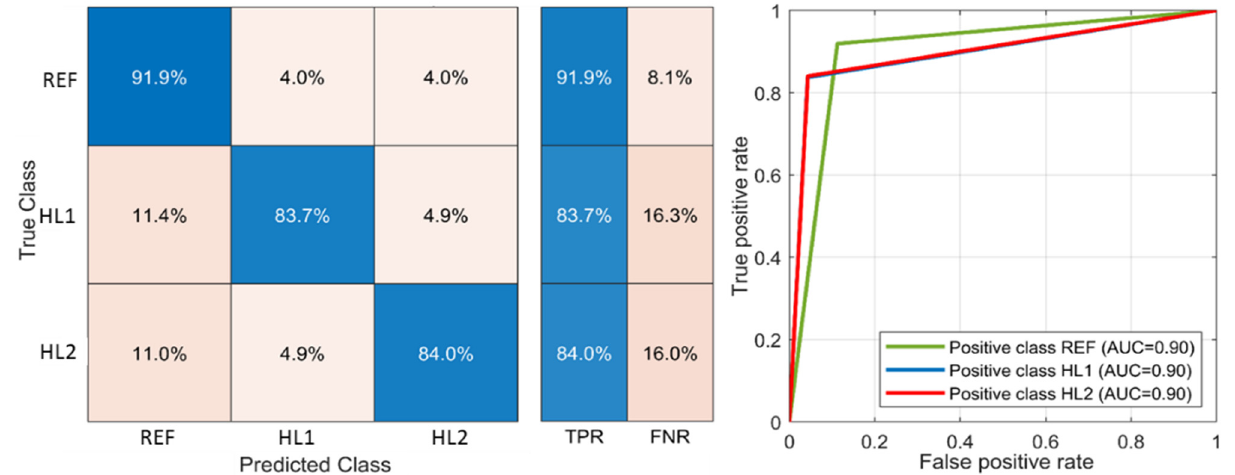
Figure 19. The misclassification matrix ( left ) and ROC-plot ( right ) for fine KNN classifier. The SVM classifier finds the optimal decision boundary with regard to the bias vari- ance trade-off. It stays accurate to the training points and makes an accurate prediction with new points. The SVM presents the advantages, compared to other machine learning techniques, that it can make both linear and non-linear classifications and can better deal with outliers than KNN. The classification results for cubic SVM is presented in Figure 20. The TPR rates for HL1 and HL2 classes are noticeably lower than for the KNN classifier due to a high misclassification rate with the REF class. The ROC curves show the best classification performance for the positive classes REF and HL2.